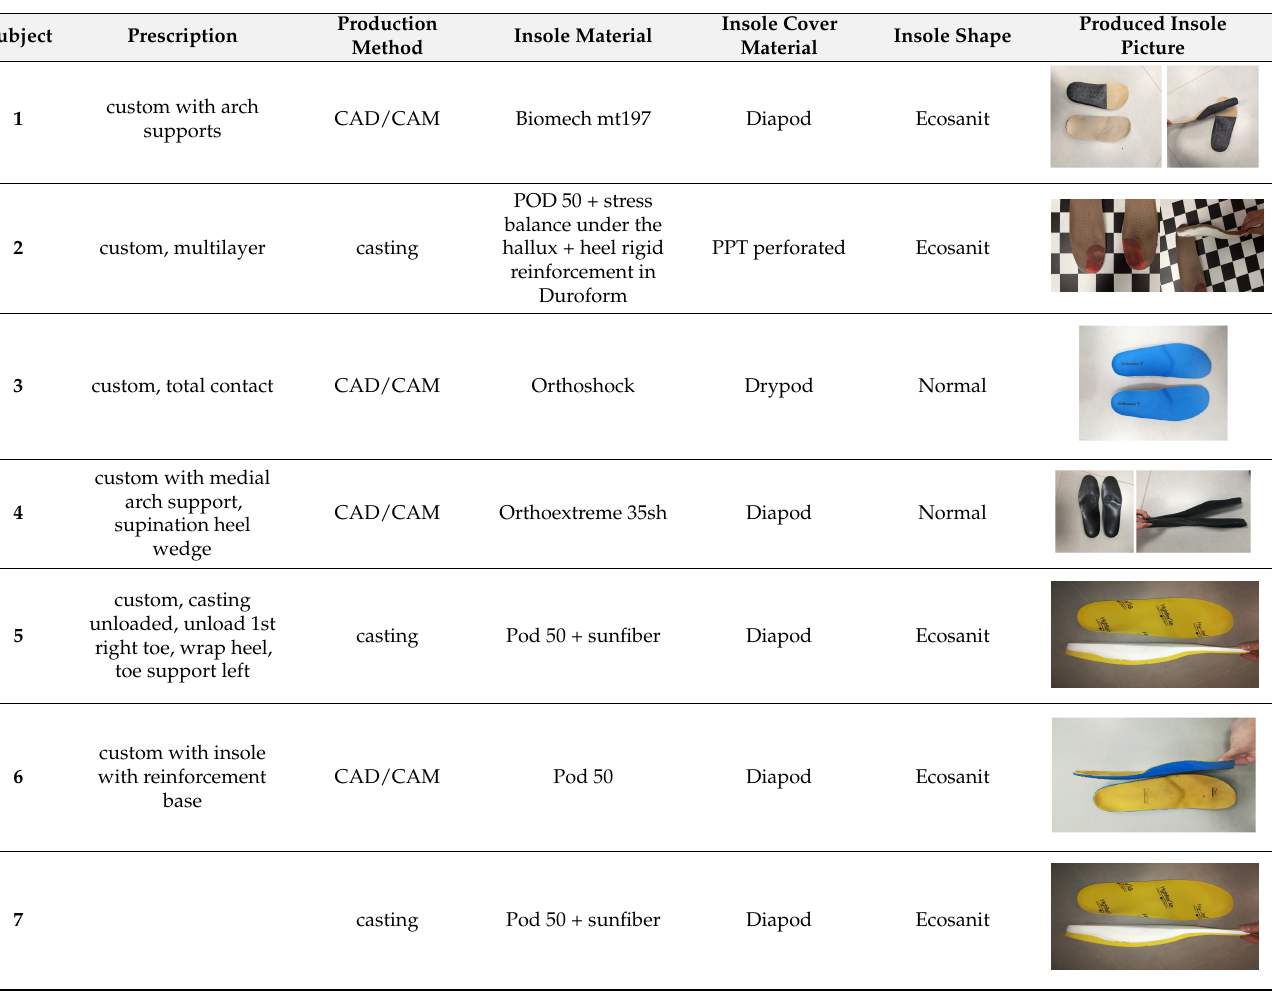
Figure 2. Details of sEMG probes location. Details of CI are reported in Table 2. Table 2. Technical details of CI.